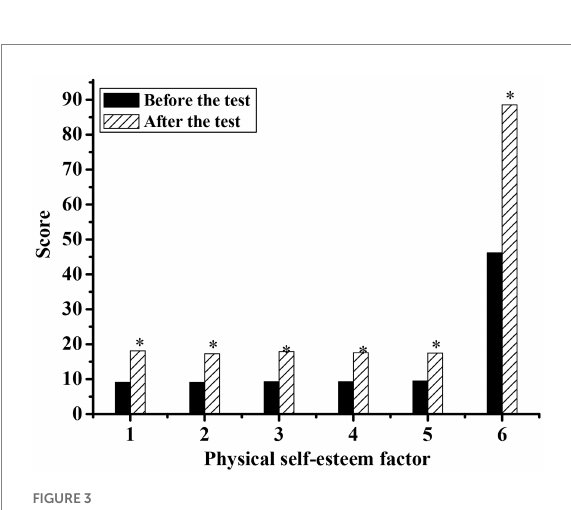
FIGURE 3 Comparison of physical self-esteem scale scores of silver-haired people in the experimental group before and after the experiment. (1: physical self-worth; 2: athletic ability; 3: physical conditions; 4: physical attraction; 5: physical fitness; 6: total score; * indicates a significant difference compared with before the test, p < 0.05).